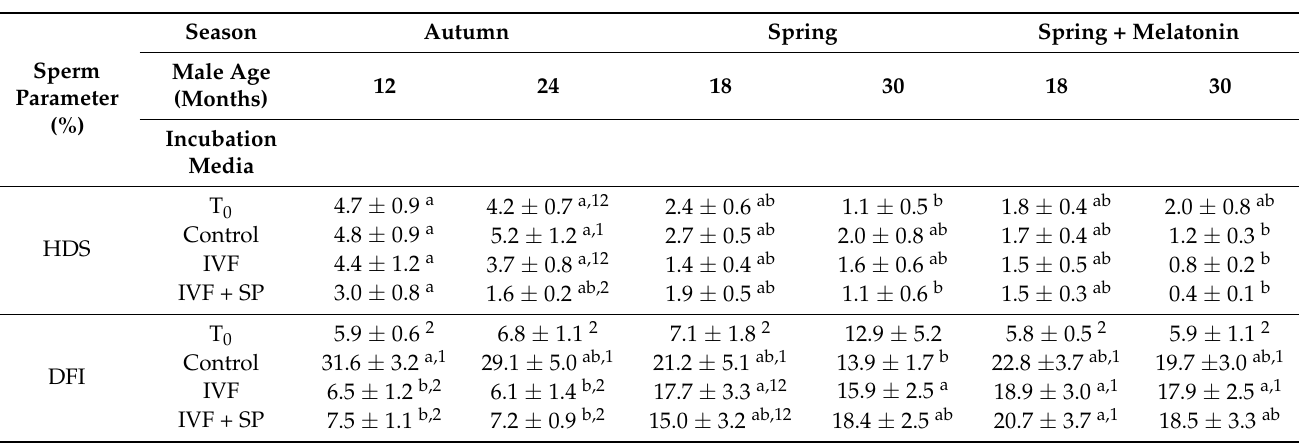
Table 2. Effect of seminal plasma and its resilience under in vitro capacitation conditions on the DNA integrity of thawed buck sperm with respect to male age (months) season, and melatonin implant.